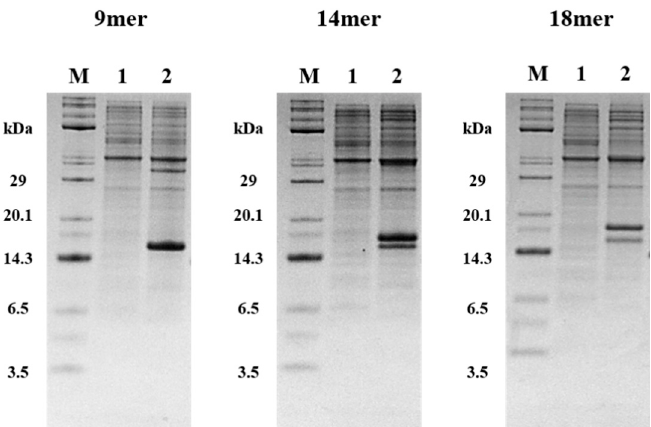
Figure 5. Tris-tricine 12% sodium dodecyl sulfate- polyacrylamide gel electrophoresis S (DS-PAGE) diagrams showing the expression of the tIK series. Lane M—molecular weight marker; lane 1—cells before IPTG induction; lane2—cellsafterIPTGinductionshowingaKSI-fusedproteinband. Theexpressed tIK series is insoluble due to KSI and thus, remains in pellet form. Therefore, it can be seen that bands